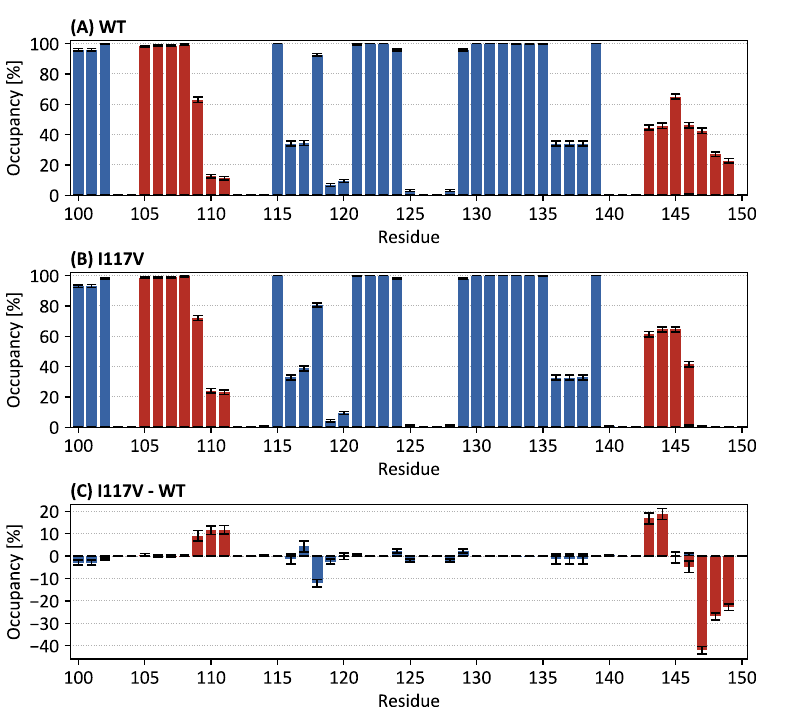
Figure 3 Secondary structure occupancies in the region containing the 100th to 150th residues for the neuraminidase-oseltamivir complexes. (A) The wild-type (WT) and (B) I117V mutant NA-OTV complexes. (C) Change in the secondary structure occupancies due to the I117V mutation. The sec- ondary structures were classi fi ed into three simpli fi ed categories: helix, sheet, and coil. The helix and sheet components are represented by red and blue bars, respectively, while the rest correspond to the coil. Error bars represent 95% con fi dence